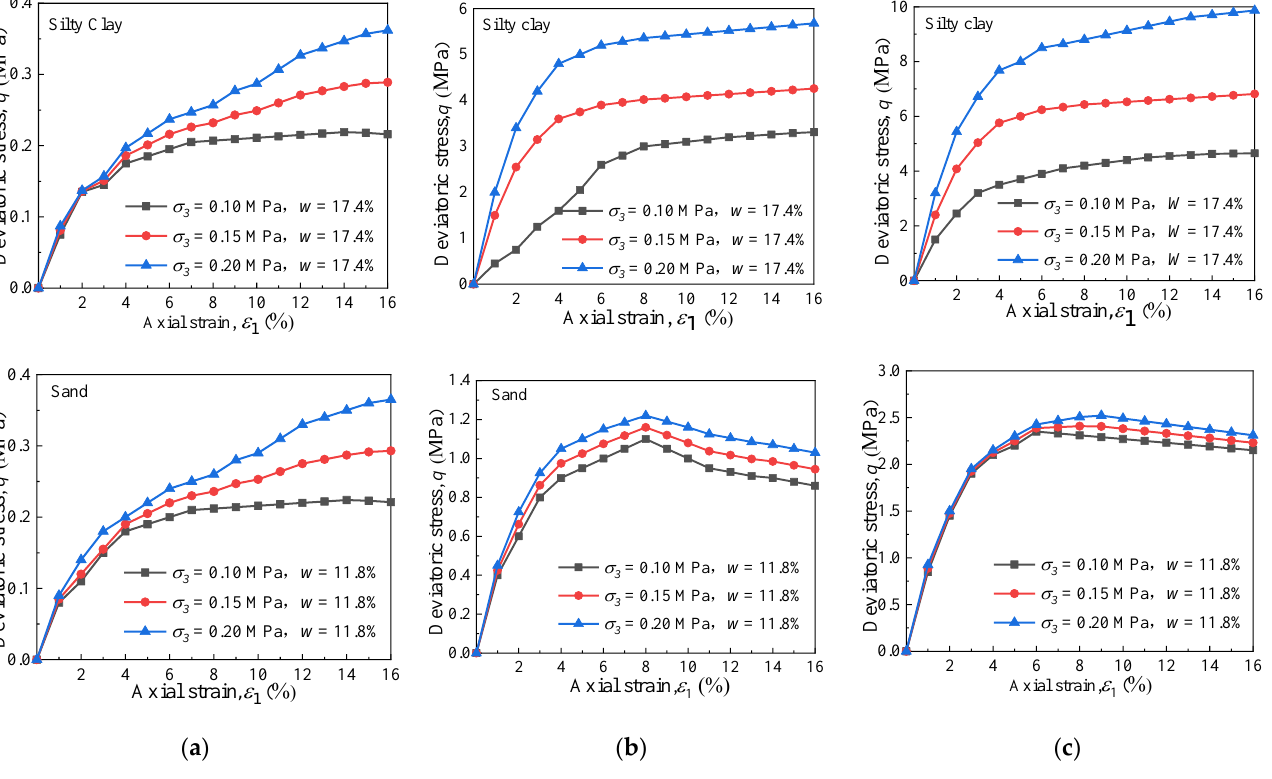
Figure 5. Dependence of deviatoric stress on the axial strain of tested remoulded fine-grained materials corresponding to different confining pressures: ( a ) T = −1 °C, ( b ) T = −5 °C, and ( c ) T = −10 °C.